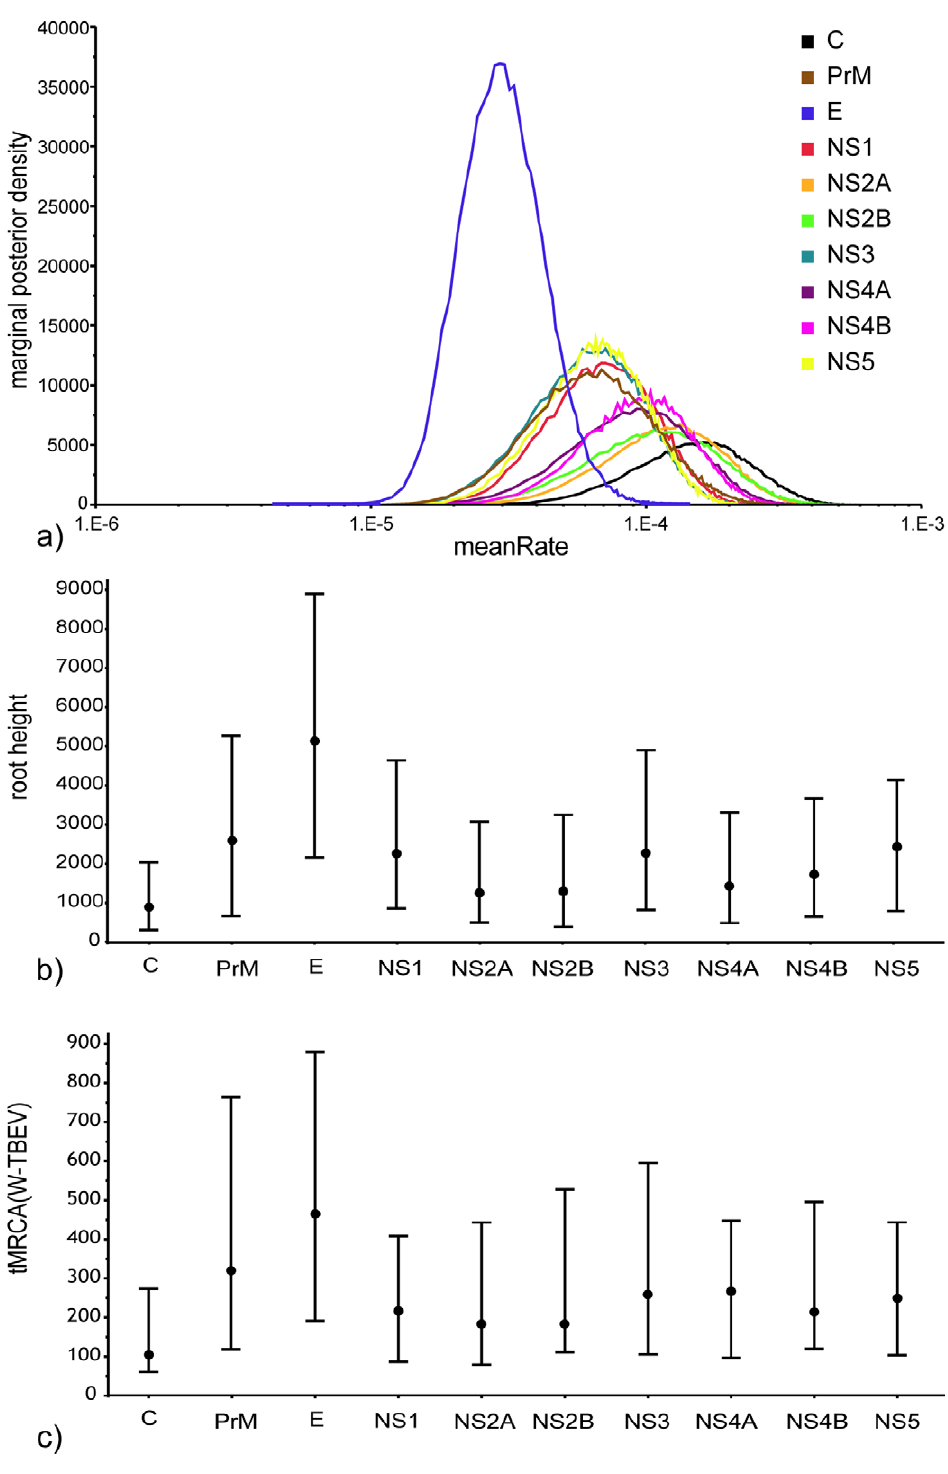
Figure 4. Effect of mean rate variation across the genome and consequences on date estimations. (a) Posterior probability distribution for the mean substitution rate (meanRate) parameter for individual genes across the full-length coding genome. (b) Root antiquity (root height) and (c) tMRCA(W-TBEV) inferred from individual genes for the 28 full-length coding sequences. doi:10.1371/journal.pone.0031981.g004 as in inference 1, yielded a mean rate estimate twice as high as Woelk et al. [47] suggested that the reduced positive selection in under a relaxed clock and, consequently underestimated all vector borne RNA viruses, results from three possible trade-offs divergence times by about a factor two (data not shown). associated with the life cycle carried in both mammalian and